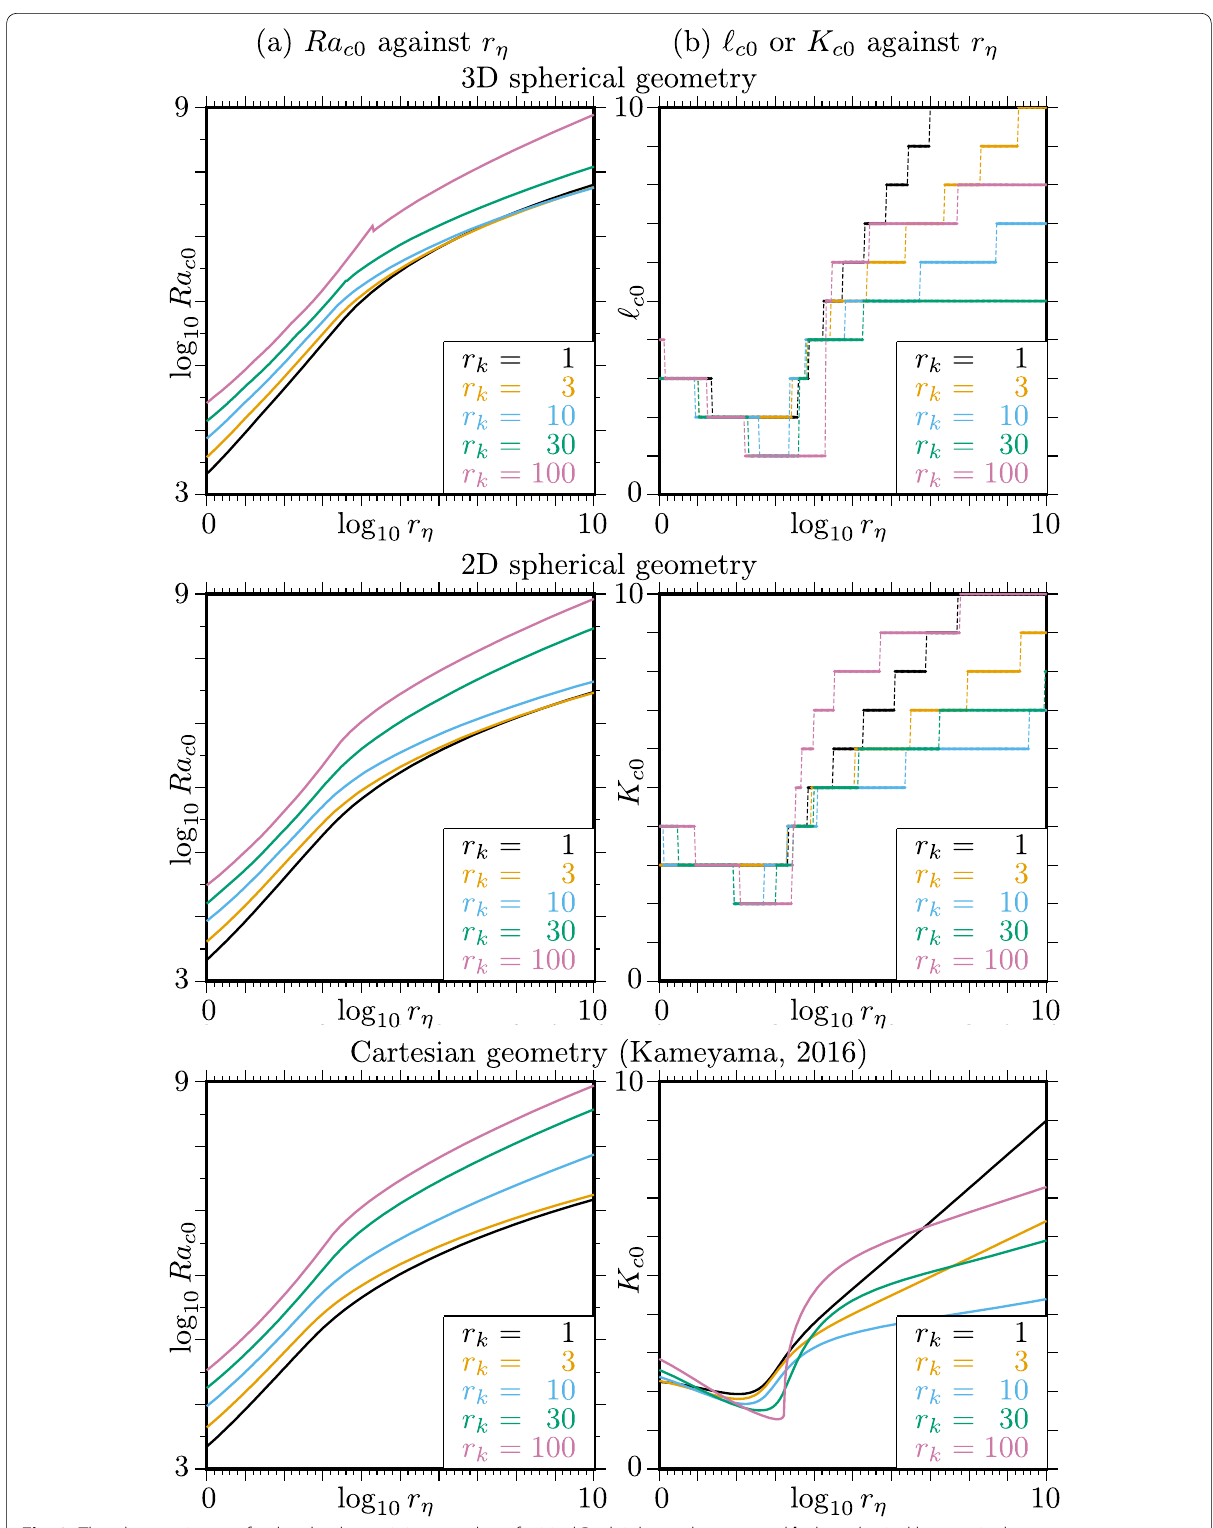
Fig. 2 The plots against r η of a the absolute minimum value of critical Rayleigh number Ra c 0 and b the spherical harmonic degree ℓ c 0 or horizontal wavenumber K c 0 of perturbation corresponding to Ra c 0 , obtained for different model geometries and various values of r k in the range of 1 ≤ r k ≤